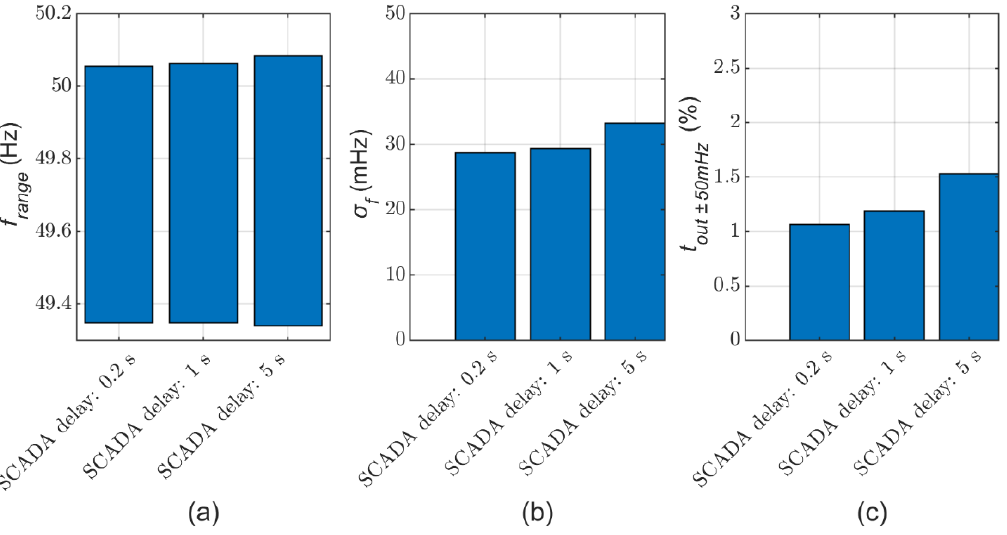
Figure 14. Frequency quality metrics, for different SCADA communication delays. ( a ) Frequency range, ( b ) frequency standard deviation, ( c ) time outside 49.95–50.05 Hz.